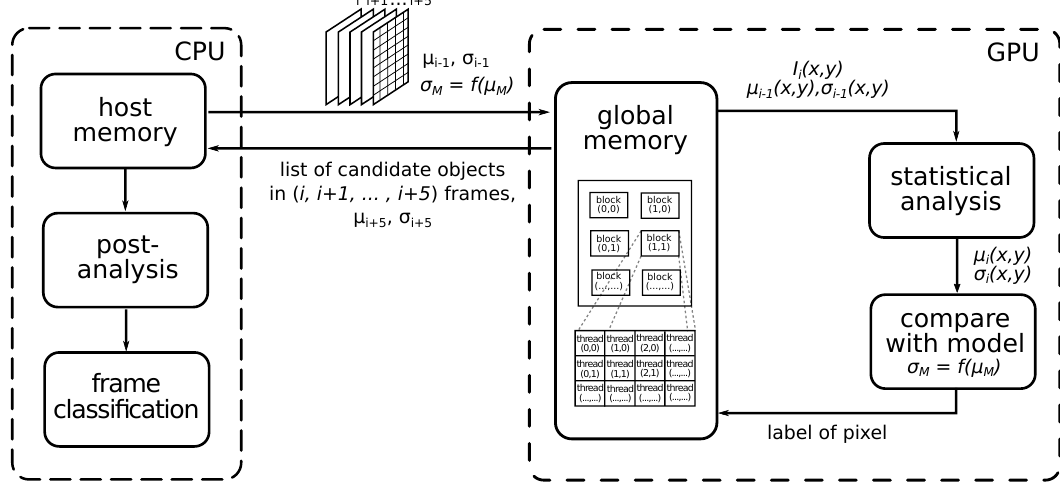
Figure 14. Block diagram of the GPU-accelerated pipeline.